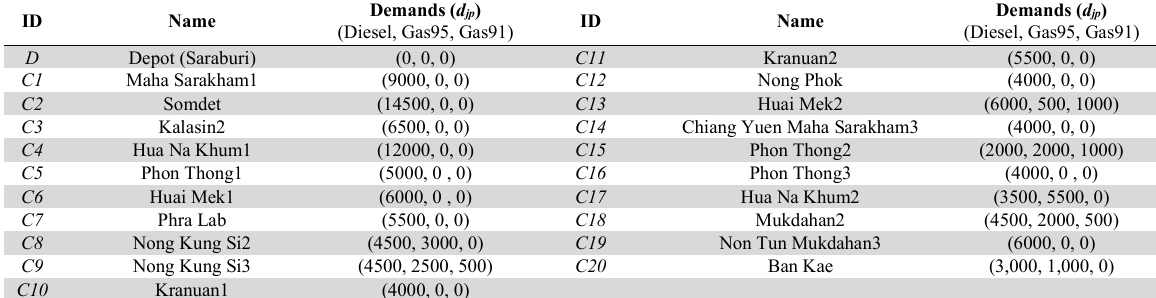
The capacity for each candidate vehicle Vehicle